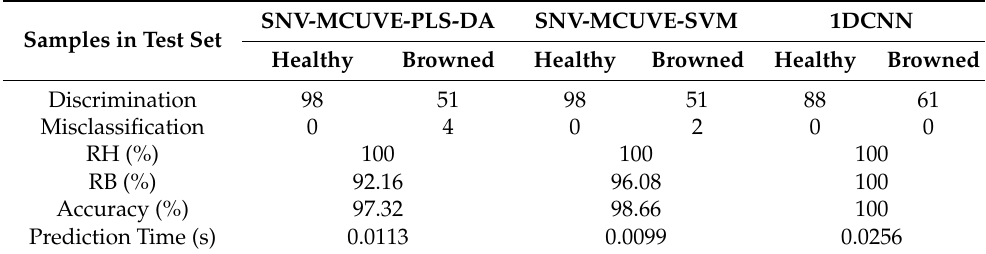
Table 5. Statistics of test results of SVM, PLS-DA, and 1D-CNN models.